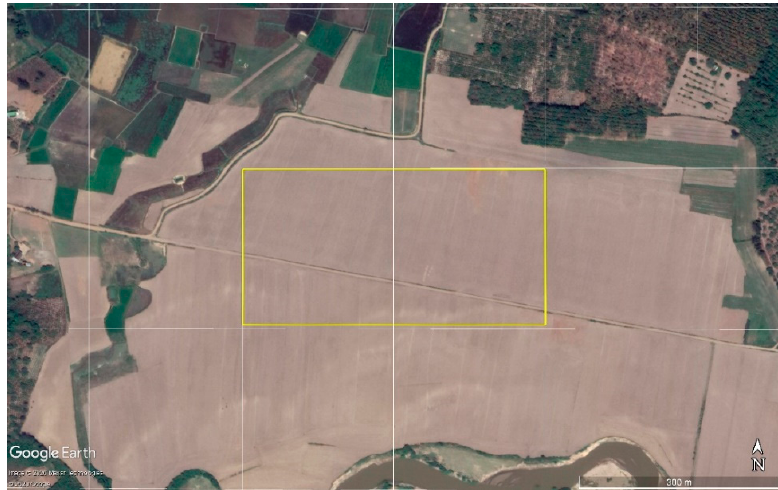
Figure 5. A training sample of 1-season maize crop class over a MOD13Q1 grid (in white) and a high spatial resolution image of Google Earth Pro taken on 18 February 2019.